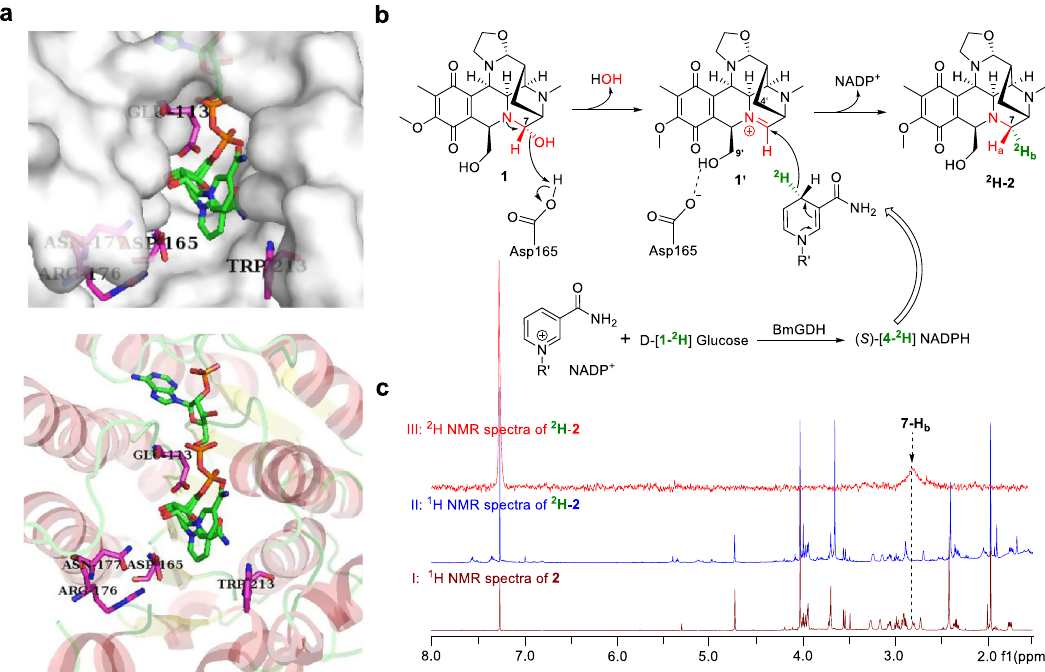
Fig. 3 Enzymology characterization of NapW-catalyzed reduction in NDM biosynthesis. a Crystal structure of NapW-NADP + complex. In this cartoon model, polar amino acids (Glu113, Asp165, Arg176, Asn177, and Trp213) around nicotinamide terminal shown as sticks. b Proposed enzymatic mechanism. c NMR analysis of enzymatic